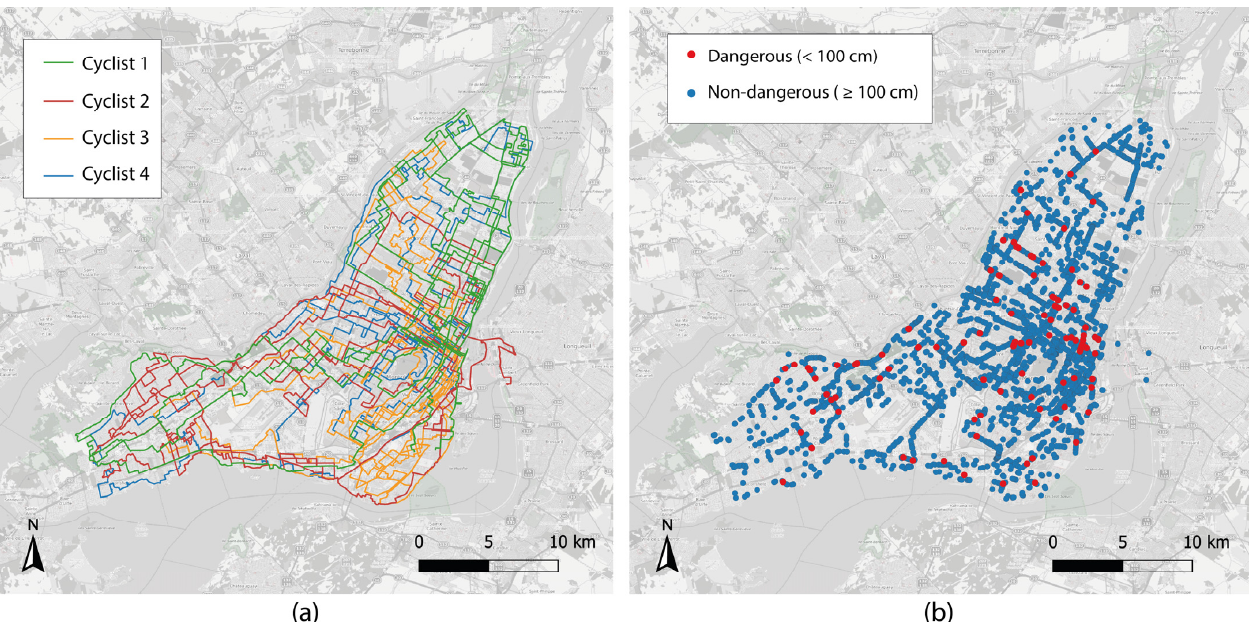
Figure 1. Data collected ( a ) Trips completed by the four participants; ( b ) dangerous overtakings or